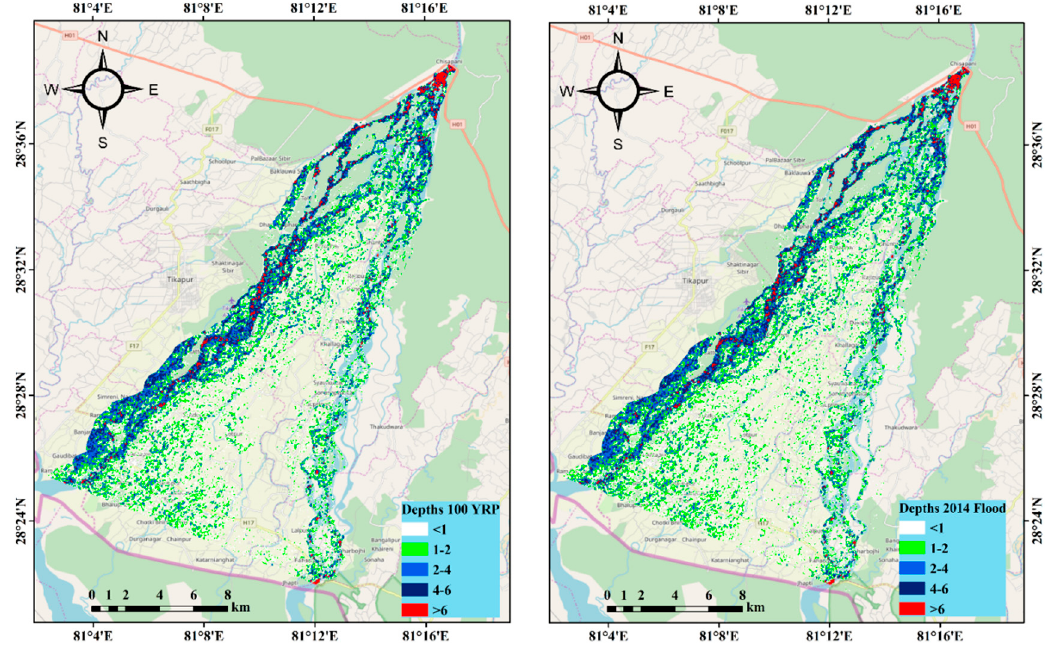
Figure 11. Flood water depths simulated by the Hydrologic Engineering Center’s River Analysis System (HEC-RAS) in the study area for the 100-YRP ( left ) and the 2014 flood (around the 100-YRP) ( right ).